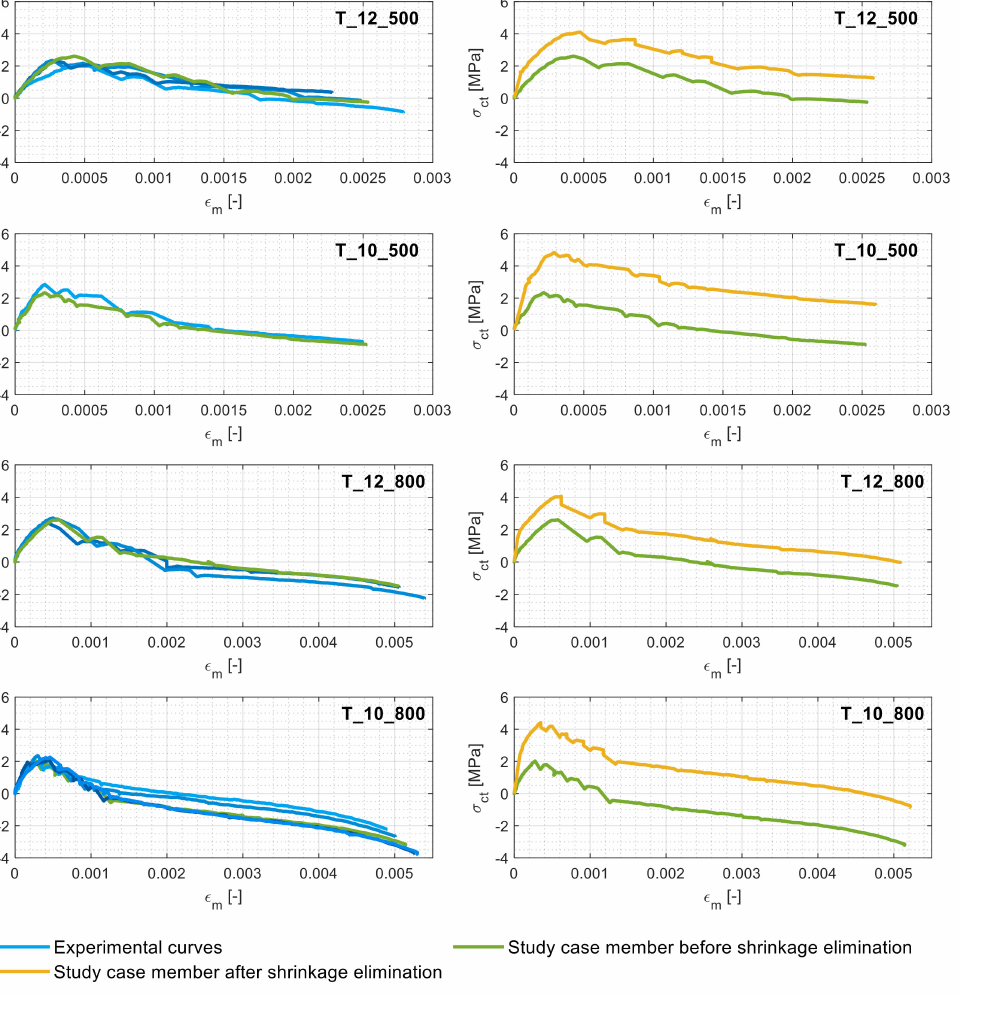
Figure 6. Tension stiffening behaviors of all the members ( left column ) and those of a study case member ( right column ) before and after shrinkage